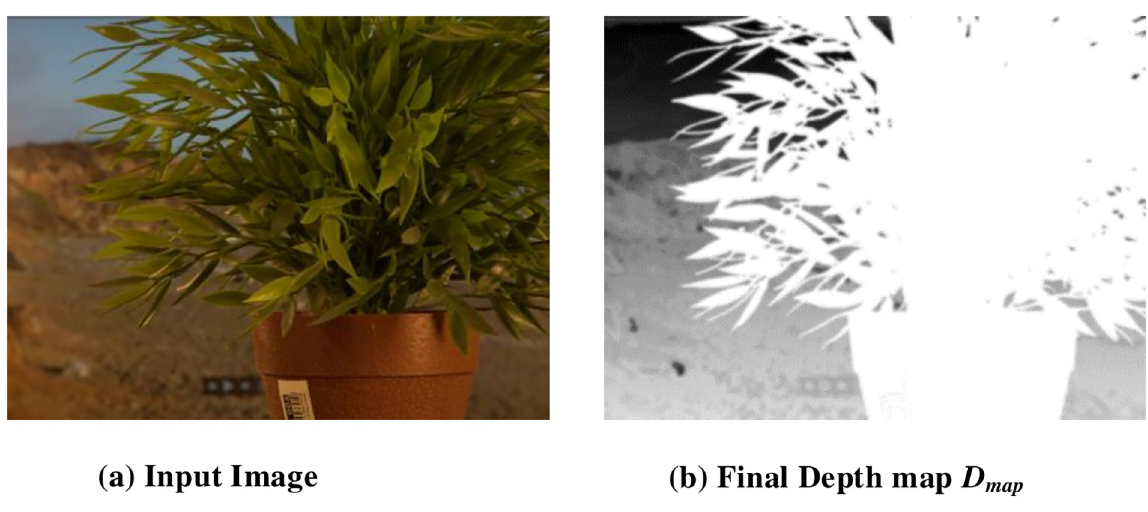
Fig 9. Refined depth map D